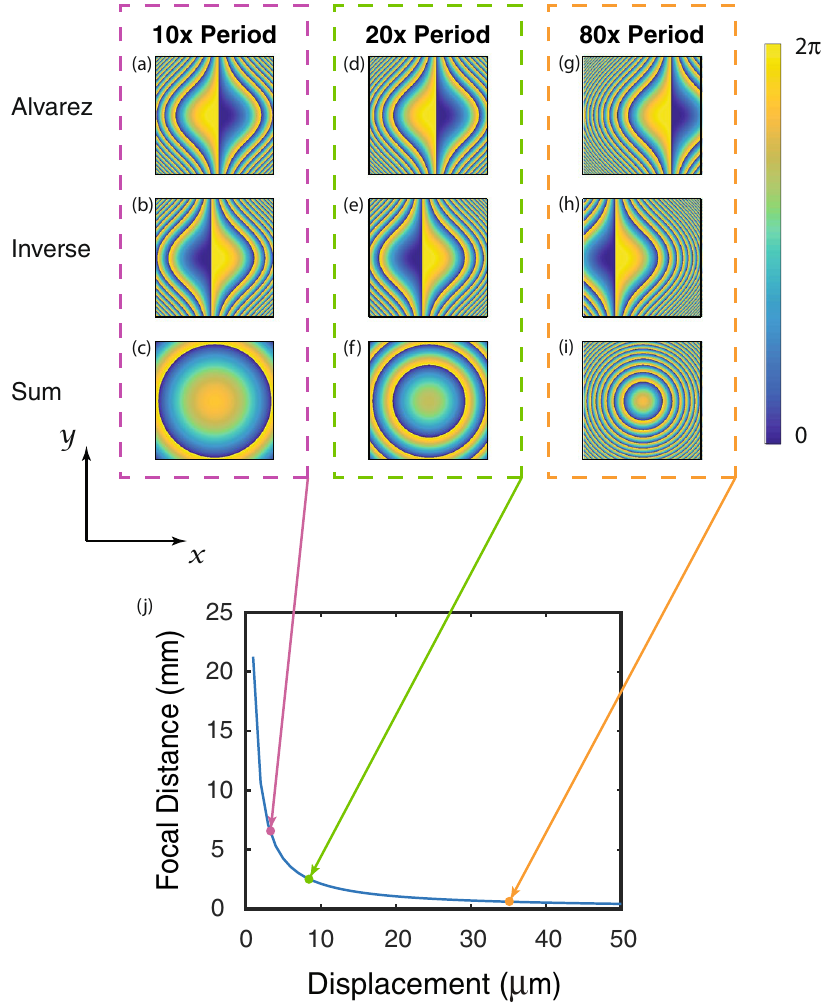
Figure 4. Behavior of the Alvarez lens in response to x displacement. ( a , d , g ) represent the phase profiles of one Alvarez element for displacements of 10p, 20p, 80p respectively, ( b , e , h ) represent their inverses at displacements of − 10p, − 20p, − 80p respectively, and ( c , f , i ) are the sums of the displaced phase profiles. The phase profiles are displaced in units of the metasurface lattice periodicity p = 443 nm, with ( a – c ) representing a 4.43 μ m displacement, ( d – f ) representing 8.86 μ m displacement, and ( g – i ) representing a 35.4 μ m displacement. ( j ) Plot of focal length dependence on displacement based on equation 4. Larger displacements result in a more rapidly varying phase profile, corresponding to a lens with a smaller focal length. The colored dots indicate the focal lengths of lenses shown in ( c , f , i ). Parameters used are the same as for the fabricated device, L = 150 μ m, A = 1.17 × 10 7 m − 2